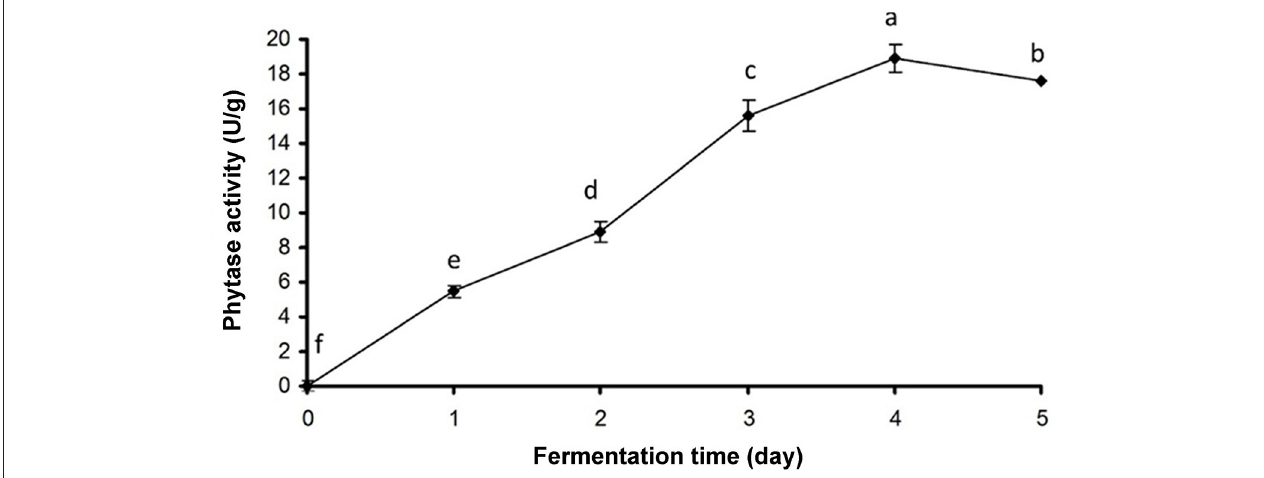
FIGURE 3 | Phytase activity of haria . Bars represent SD values of replicates. Values are the mean ( ± SD) of phytase activity ( F = 851.341; df = 5, 24; P < 0.001). Different letters on the bars are significantly different ( P < 0.001) in Duncan’s multiple range